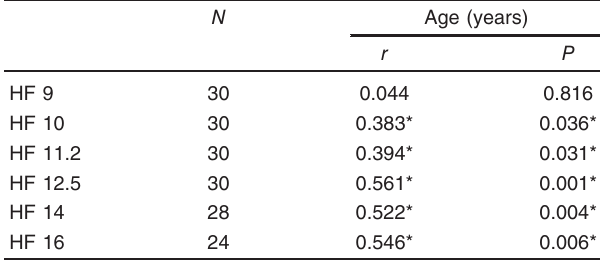
Table 9 Correlation between age and high frequency thresholds in control group